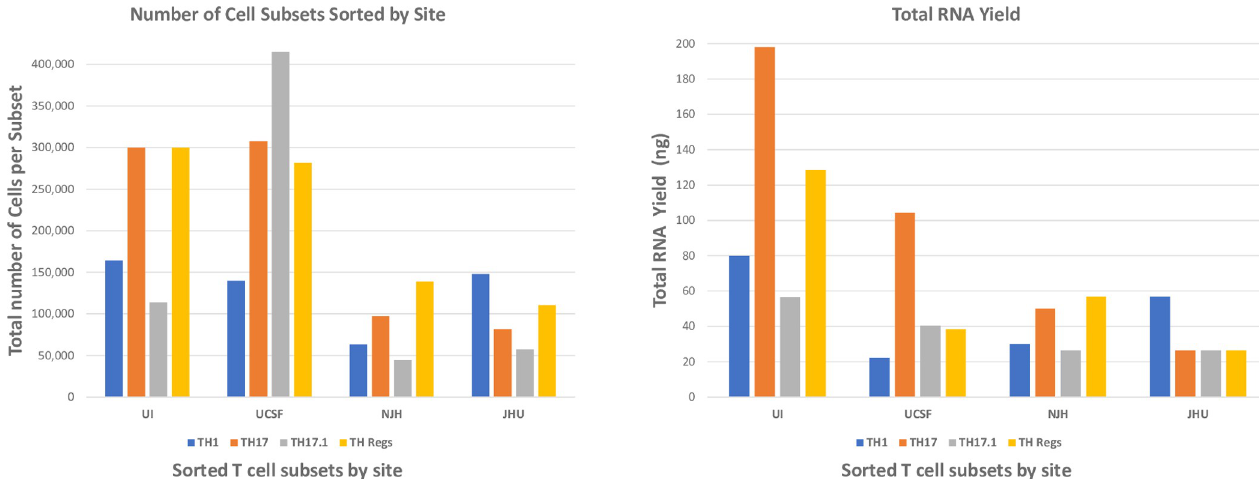
Fig 5. Cell number and RNA quantity obtained after cell sorting. CD4+ T cell subsets were flow sorted from PBMCs at each site using the final flow panel shown in Fig 3. Sorted populations were lysed to preserve RNA and shipped to the central laboratory where total RNA was isolated. A) Number of cells sorted in each subset by each site from one sample. There was only one sample per test, thus no error bars are added. B) Total RNA mass obtained after extractions based on number of cells sorted per site per subset.